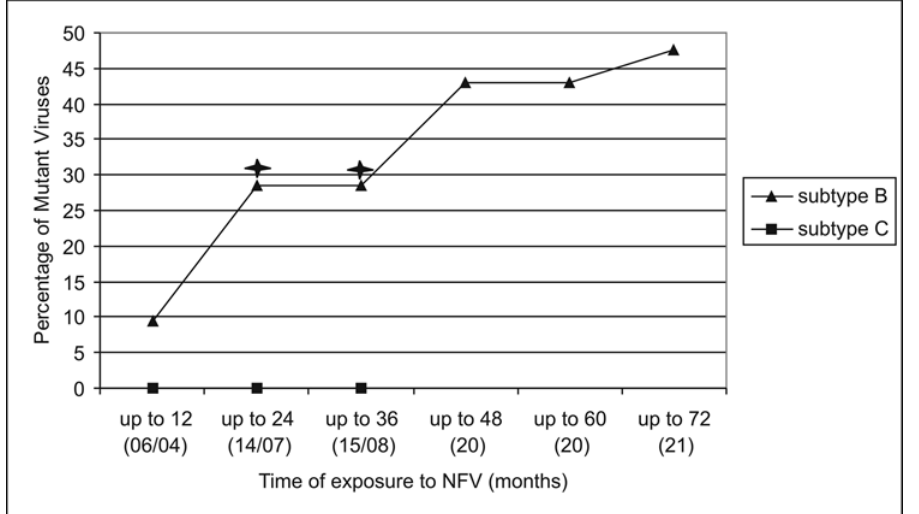
Figure 3. HIV-1 subtype B and C viruses with protease resistance mutations from individuals undergoing NFV-based HAART. Different treatment exposure periods (in months) for that drug were plotted for each subtype. Black asterisks denote significance in the difference of proportions between subtypes B and C at the 0.05 p value level.